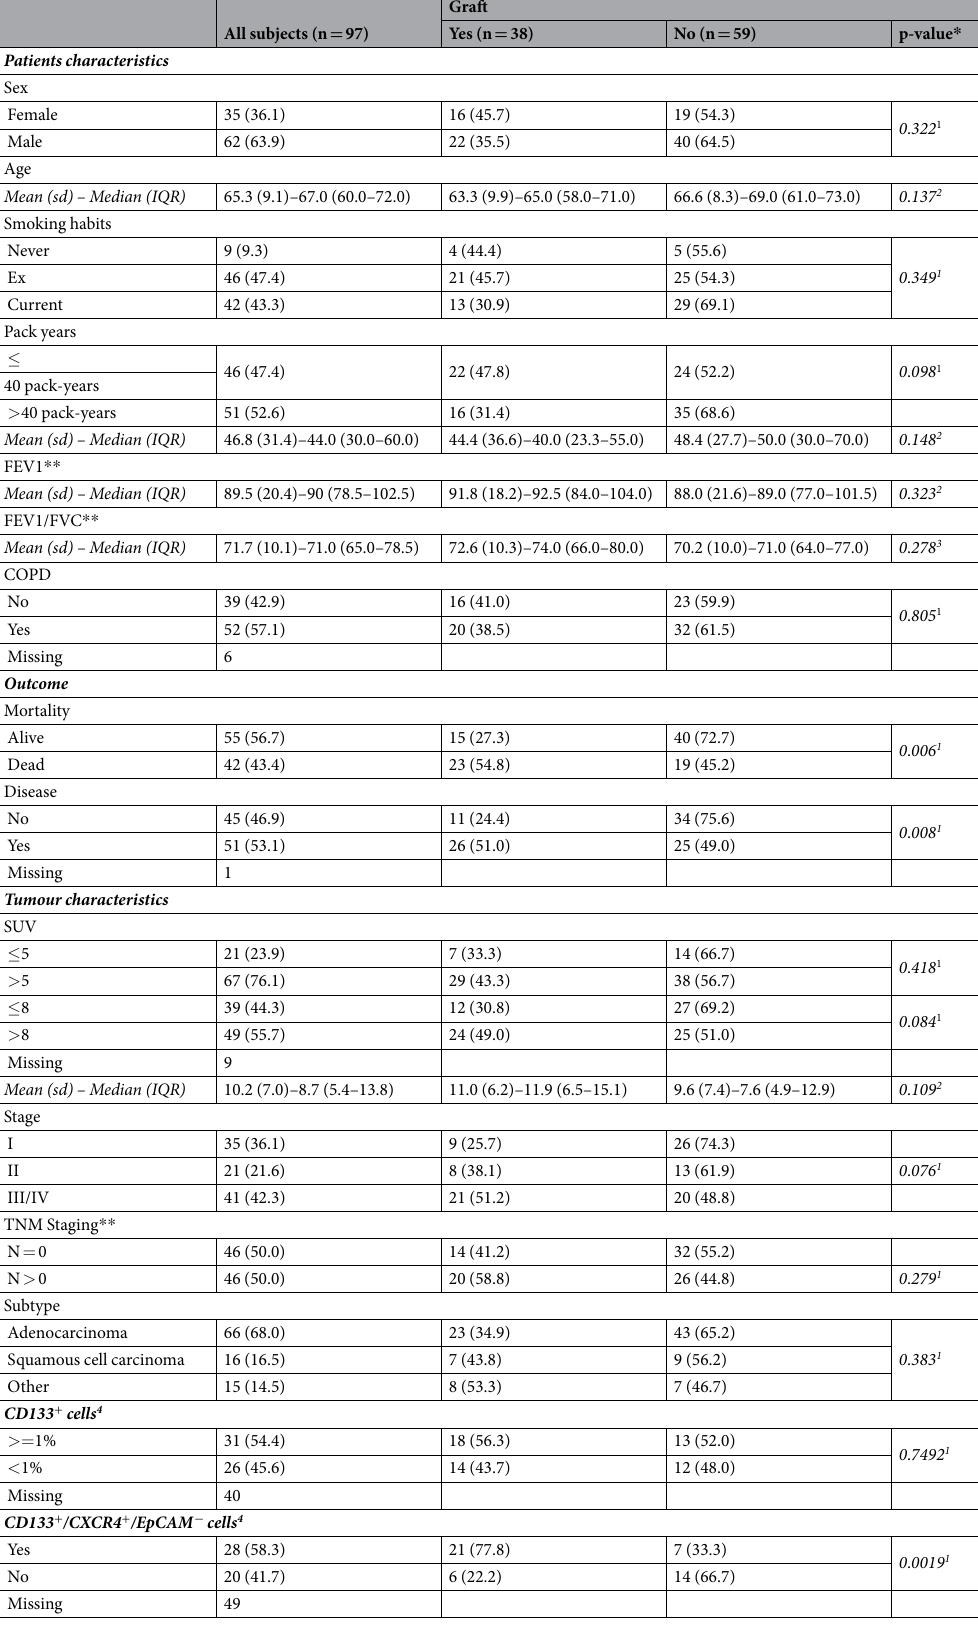
Table 1. Patients and tumours characteristics, overall and according to graft. * P for group comparison: 1 Chi- square test; 2 Wilcoxon’s rank-sum test; 3 Student’s t-test; 4 PDXs values; ** 5 missing values. SUV: Standard Upatake Value; COPD: Chronic Obstructive Pulmonary